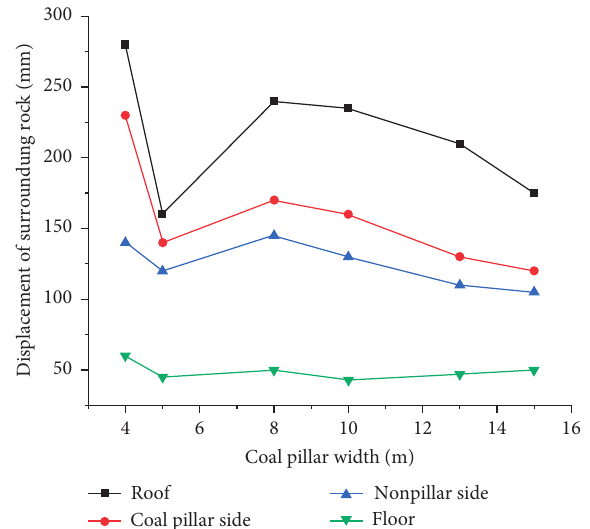
Figure 19: Displacement curves of coal pillars with different widths.